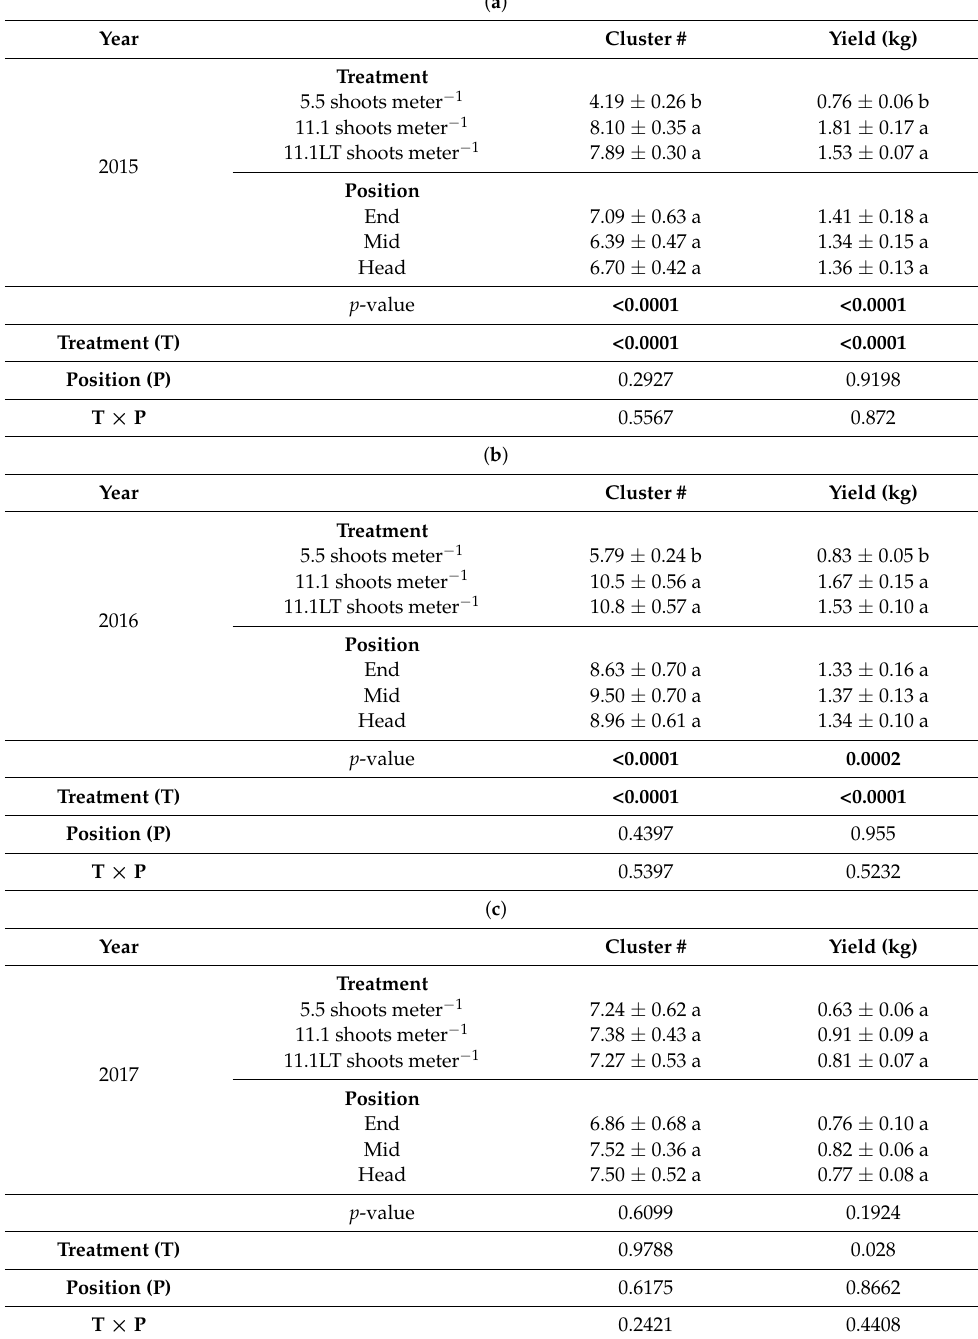
Table 7. Two-way analysis of variance (ANOVA) with interaction showing average cluster number and yield (kg) by year, treatment, and cordon position at harvest during the 2015 ( a ), 2016 ( b ), and 2017 ( c ) growing seasons ( n = 7). Table shows treatment and cordon position means followed by the standard error of the mean. Different letters within a column indicate significant differences based on an Each pair, Student’s t -test. Significant p -values (<0.05) are displayed in